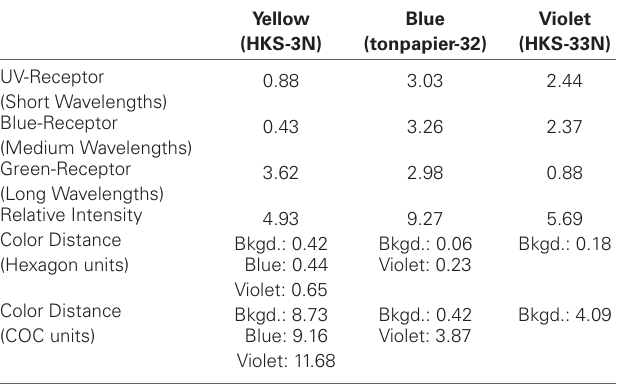
Table 1 | Photoreceptor contrasts, relative intensity and color distances of the stimuli